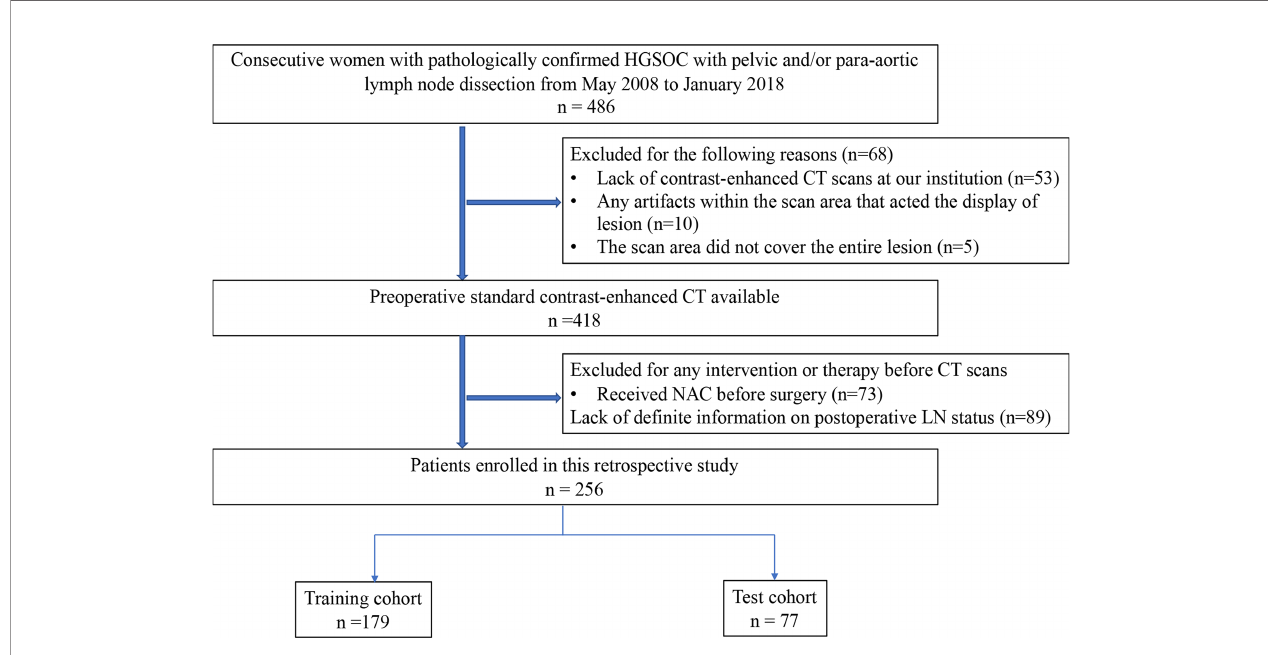
FIGURE 1 | Recruitment pathway for the patients in this